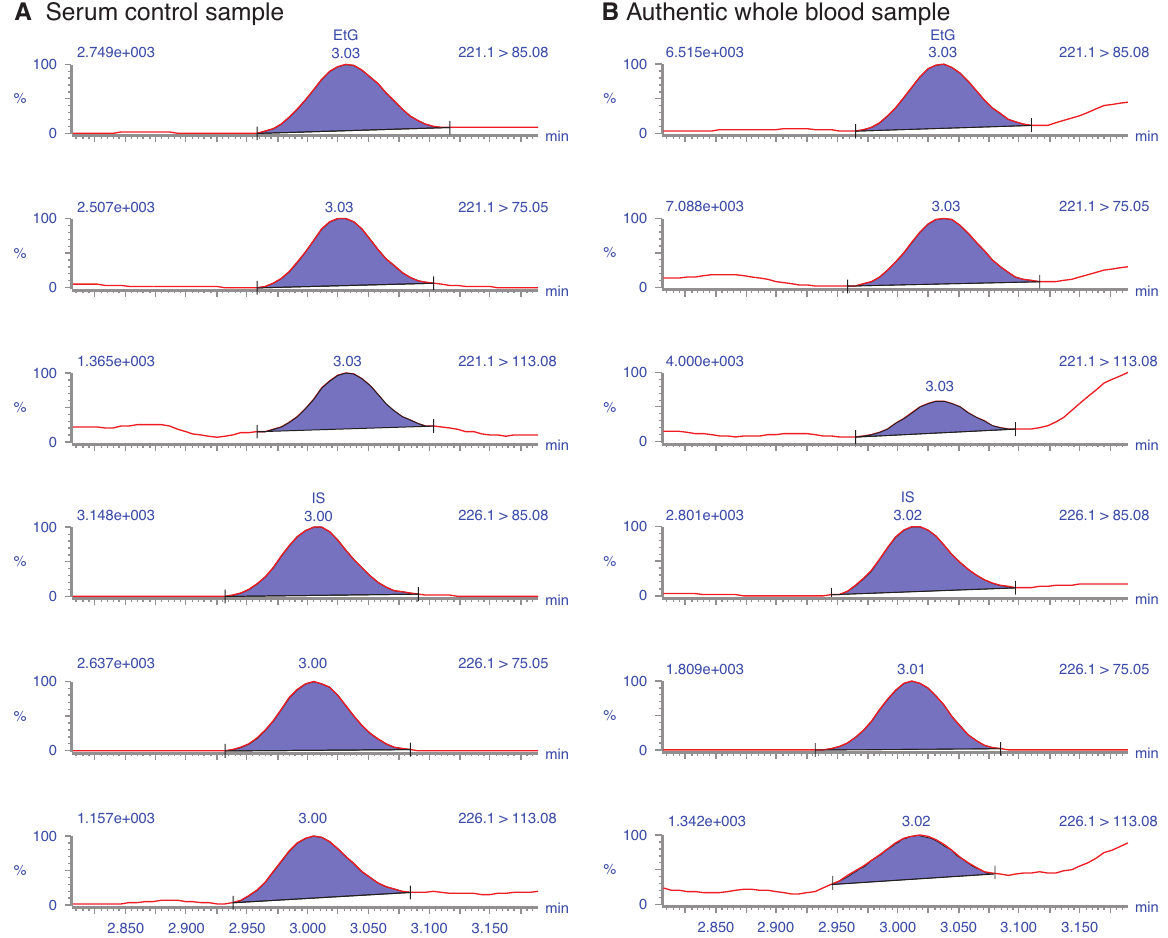
Figure 1: Chromatograms obtained from the analysis of ethyl glucuronide (EtG) in serum and blood samples. Results are (A) a low serum control sample (0.75 μ g/L), (B) a positive whole-blood patient sample (2.0 μ g/L), (C) a positive serum patient sample (1.9 μ g/L) and (D) a positive urine patient sample (553 μ g/L). The three upper traces represent the different transitions